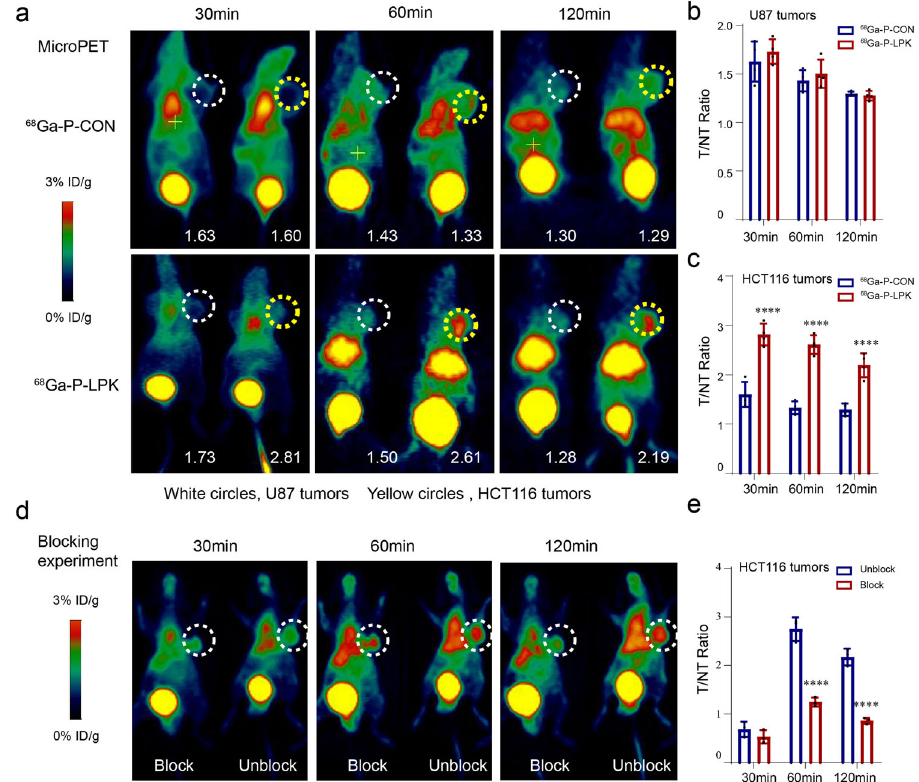
Fig. 2 MicroPET imags of 68 Ga-P-LPK in U87 and HCT116 tumor – bearing nude mice. a Whole-body coronal microPET images of U87 and HCT116 tumor- bearing mice ( n = 4) at 30, 60, and 120 min after injection of 68 Ga-P-LPK or 68 Ga-P-CON (white circles, U87 tumors; yellow circles, HCT116 tumors). The quanti fi cation values of tumor were showed in the lower right corner of mice. b , c In contrast with 68 Ga-P-CON, the T/NT ratios of 68 Ga-P-LPK was signi fi cantly increased in the HCT116 tumor-bearing mice ( b ) but not in U87 tumor-bearing mice ( c ), suggesting that 68 Ga-P-LPK speci fi cally binds to CRC tissues ( n = 4, means± SD, HCT116 30 min: 68 Ga-P-CON vs 68 Ga-P-LPK, p < 0.0001; 60 min: 68 Ga-P-CON vs 68 Ga-P-LPK, p < 0.0001; 120 min: 68 Ga-P- CON vs 68 Ga-P-LPK, p < 0.0001) (**** p < 0.0001). The prominent uptake of 68 Ga-peptide was observed at the bladder at early time points (30 min), suggesting that this tracer may be excreted through the urinary route. d , e After blocking with unlabeled peptide, the T/NT ratios was signi fi cantly reduced at 60 min and 120 min ( n = 3, means ± SD, 30 min: Unblock vs block, p = 0.7512; 60 min: Unblock vs block, p < 0.0001; 120 min: Unblock vs block, p < 0.0001) (**** p <